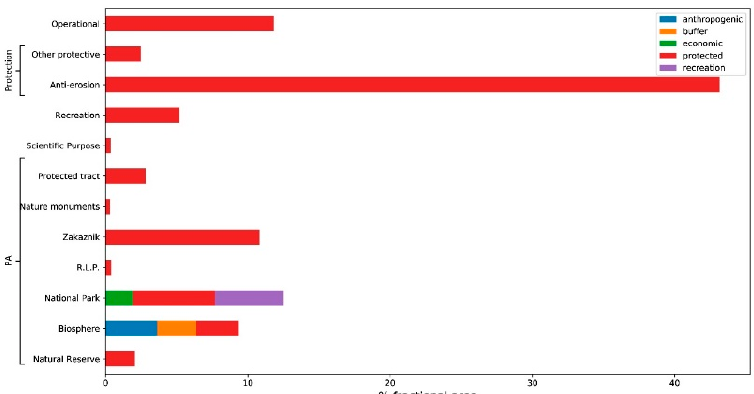
Figure 3. Fractional area of old-growth forest covered by various protection categories. For National park and Biosphere reserves zoned areas are shown. R.L.P. is Regional Landscape Park, PA is Protected